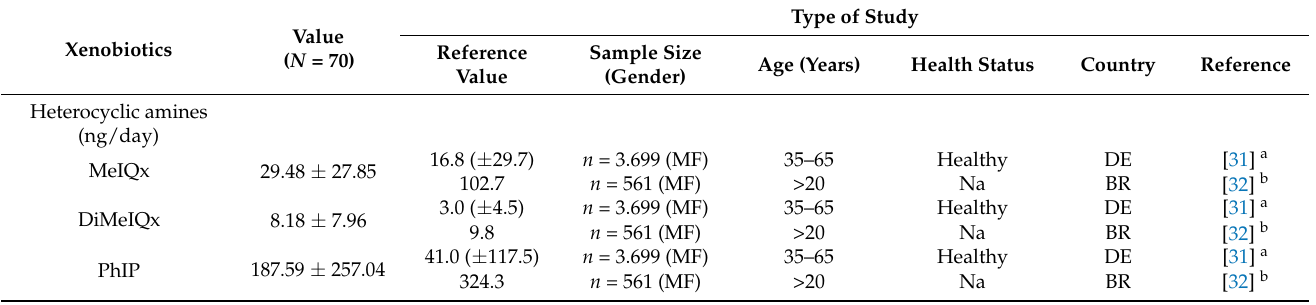
Table 3. Comparison between mean xenobiotic intake in the study sample with other studies using EPIC and CHARRED